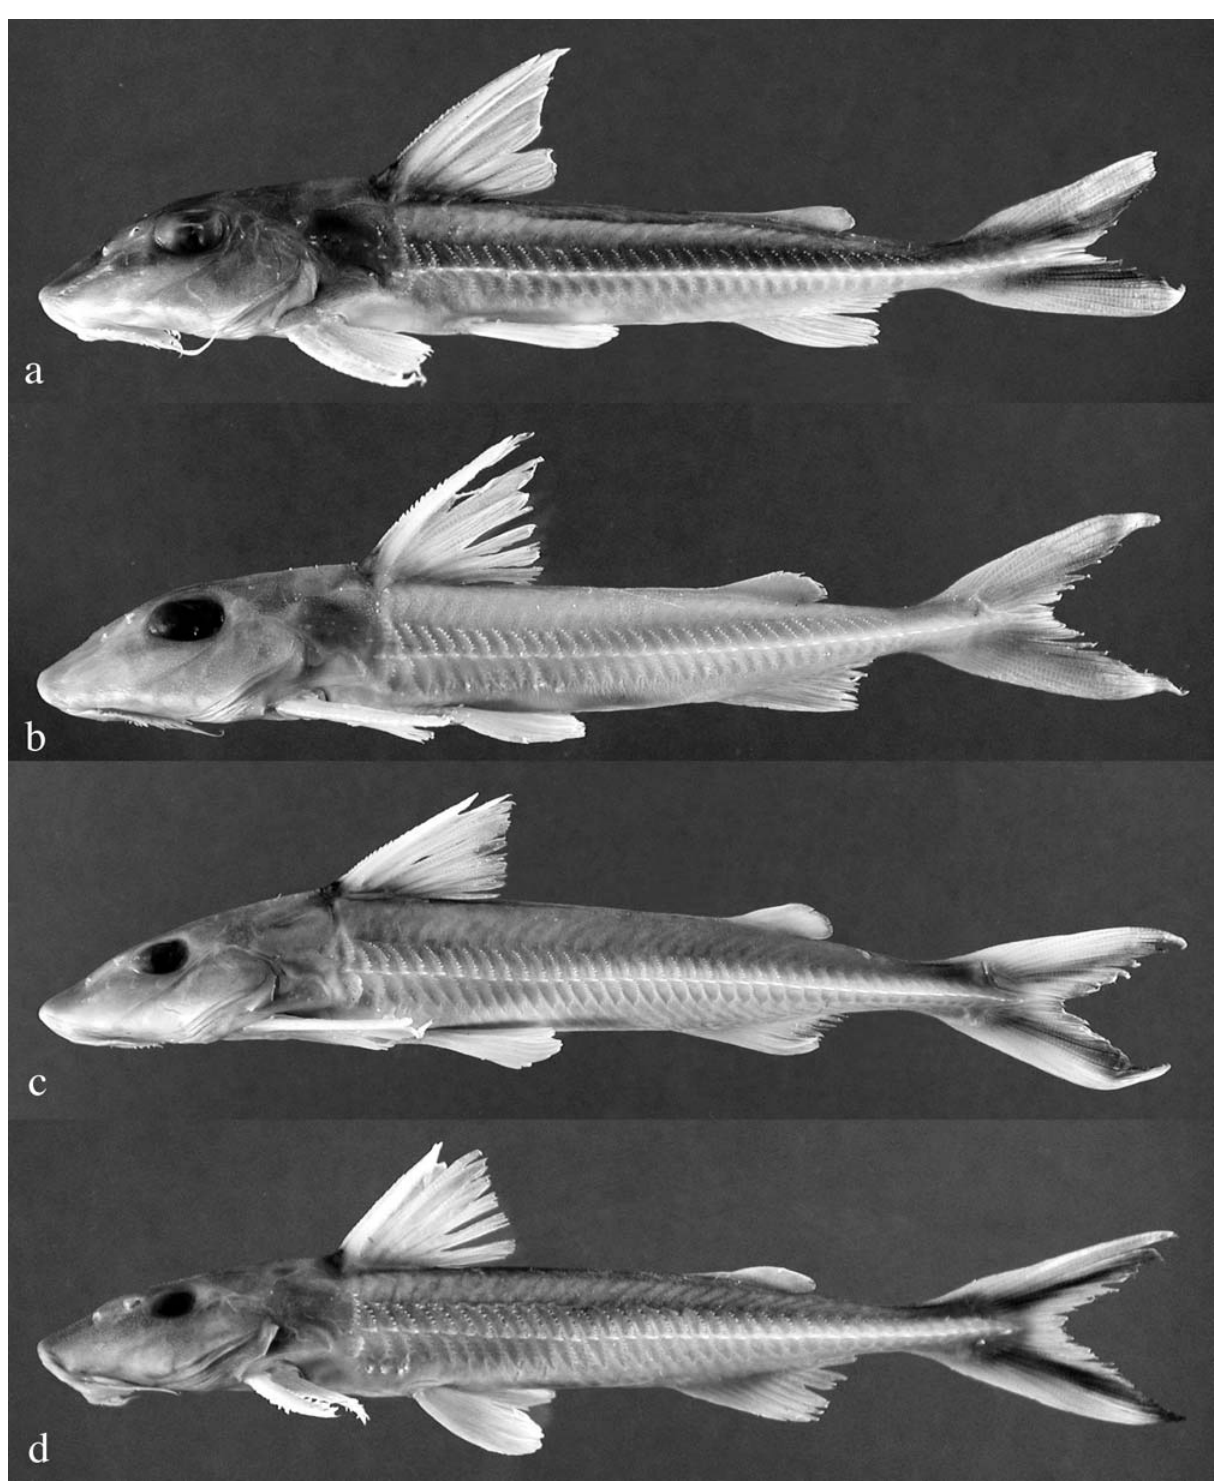
Fig. 15. Juvenile and subadult Leptodoras (Orinoco and Essequibo basins). a. L. linnelli , ANSP 175881 (SL 100.1 mm), Essequibo river, Guyana. b. L. linnelli , MBUCV-V 19689 (SL 100.5 mm), río Mavaca (Orinoco dr.), Amazonas, Venezuela. c. L. rogersae , paratype, MBUCV-V 13372 (SL 128.8 mm), río Orinoco, Delta Amacuro, Venezuela. d. L. nelsoni , paratype, MBUCV- V 14769 (SL 104.5 mm), río Apure, Apure,